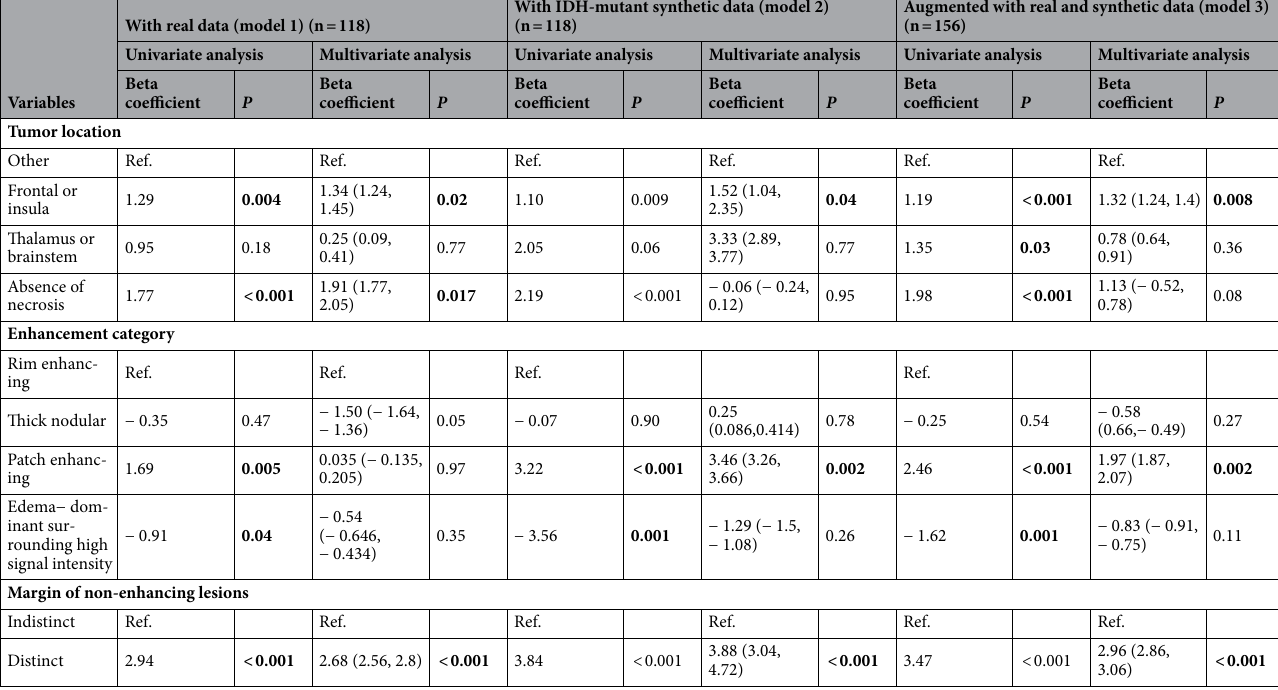
Table 2. Univariable and multivariable binomial logistic regression analysis of factors predicting IDH mutation in the training dataset. Data in parentheses are 95% confidence intervals.